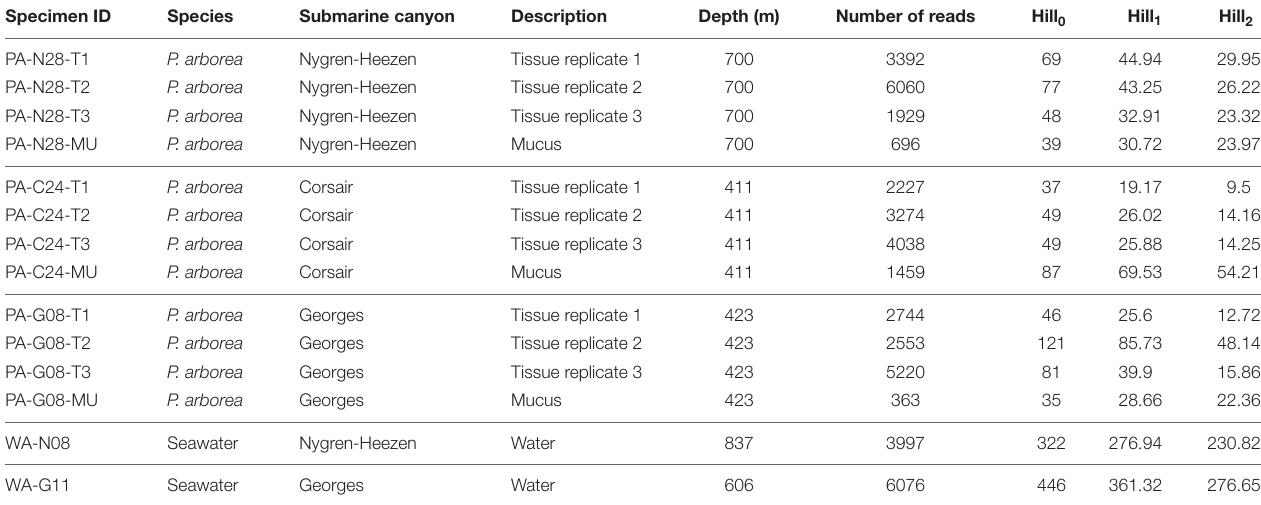
TABLE 1 | Sample collection, description, number of reads from processed data, and Hill’s series diversity summary statistics of bacterial communities determined by analysis of 16S rRNA sequence libraries. Specimen